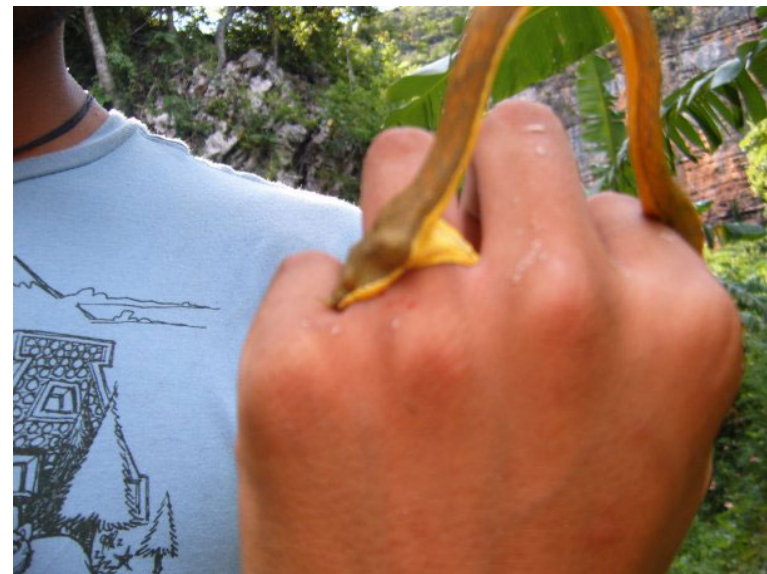
Figure 1. Langaha madagascariensis biting the subject.